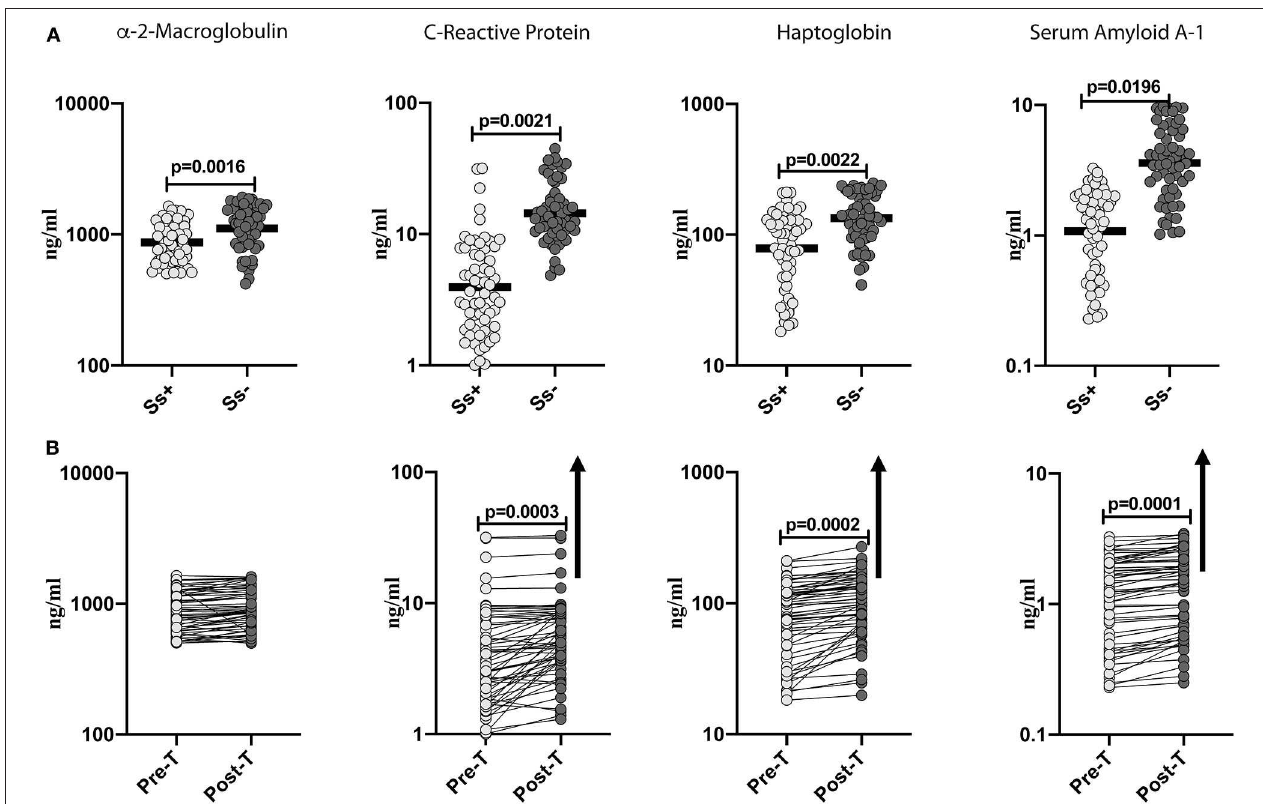
FIGURE 1 | Diminished systemic levels of acute phase proteins in helminth-diabetes comorbidity and partial reversal after anthelmintic treatment. (A) Plasma levels of a-2 Macroglobulin, C-reactive protein (CRP), haptoglobin, and Serum Amyloid A-1 (SAA-1) from Ss infected [ Ss + ] ( n = 60) or uninfected [ Ss − ] ( n = 58) individuals were measured by multiplex assay. Data are shown as scatter plots with the bar representing the geometric mean. p -values were calculated using the Mann-Whitney U-test with Holms correction for multiple comparisons. (B) Plasma levels of a-2 Macroglobulin, C-reactive protein (CRP), haptoglobin, and serum amyloid proteins (SAA), from Ss -infected individuals at pre-treatment [pre-T] ( n = 60) and at 6 months following treatment [post-treatment (post-T)] were measured by multiplex assay. The arrow shows the directionality of the significance. p -values were calculated using the Wilcoxon matched pair